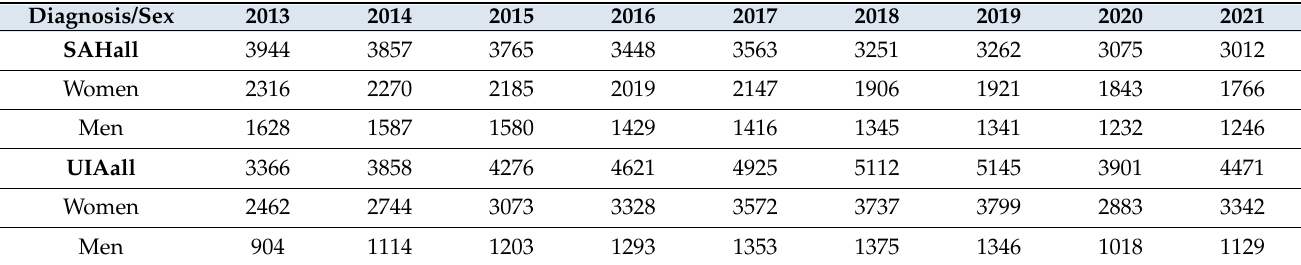
Table 1. The number of patients with an identified diagnosis by year.